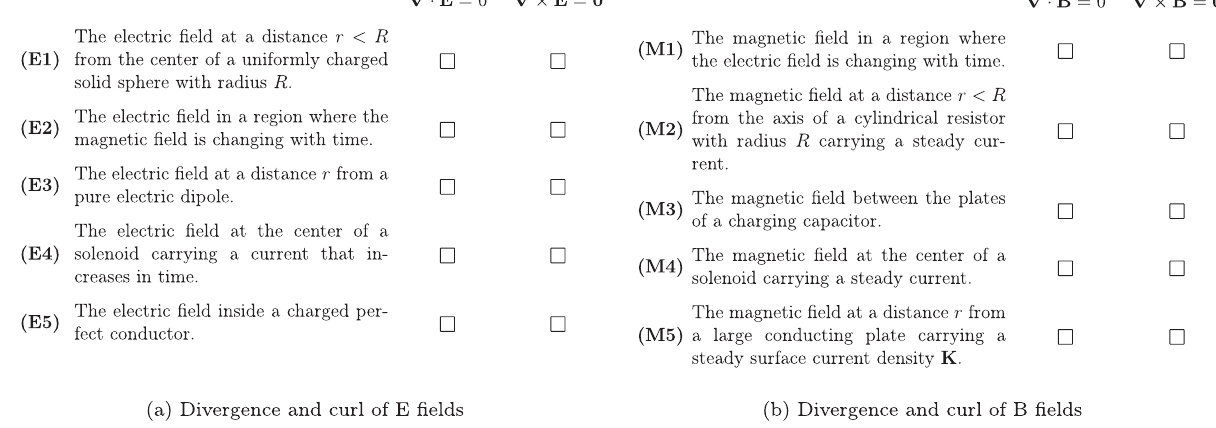
FIG. 13. Post-test question on Maxwell ’ s equations.